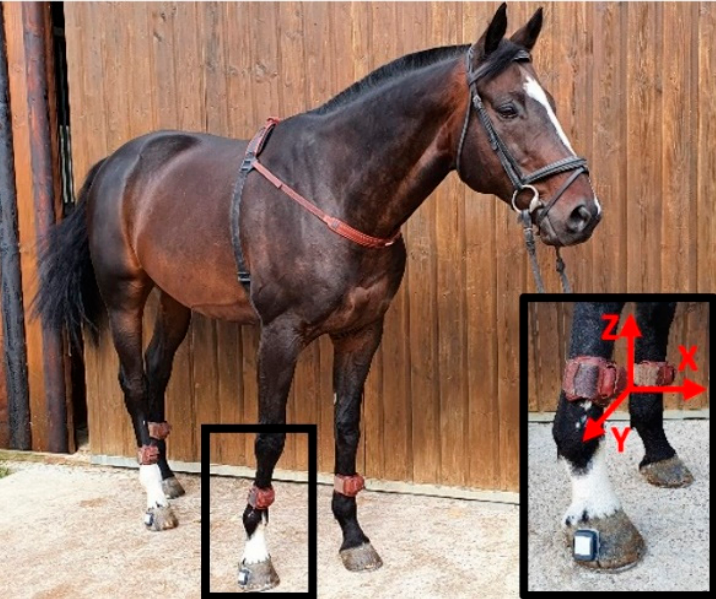
Figure 1. IMUs localization on horse: on the withers, on the four limbs, in the center of the dorsal side of the third metacarpal bone (cannon bone), and on the lateral quarter of the right front and hind hoof.